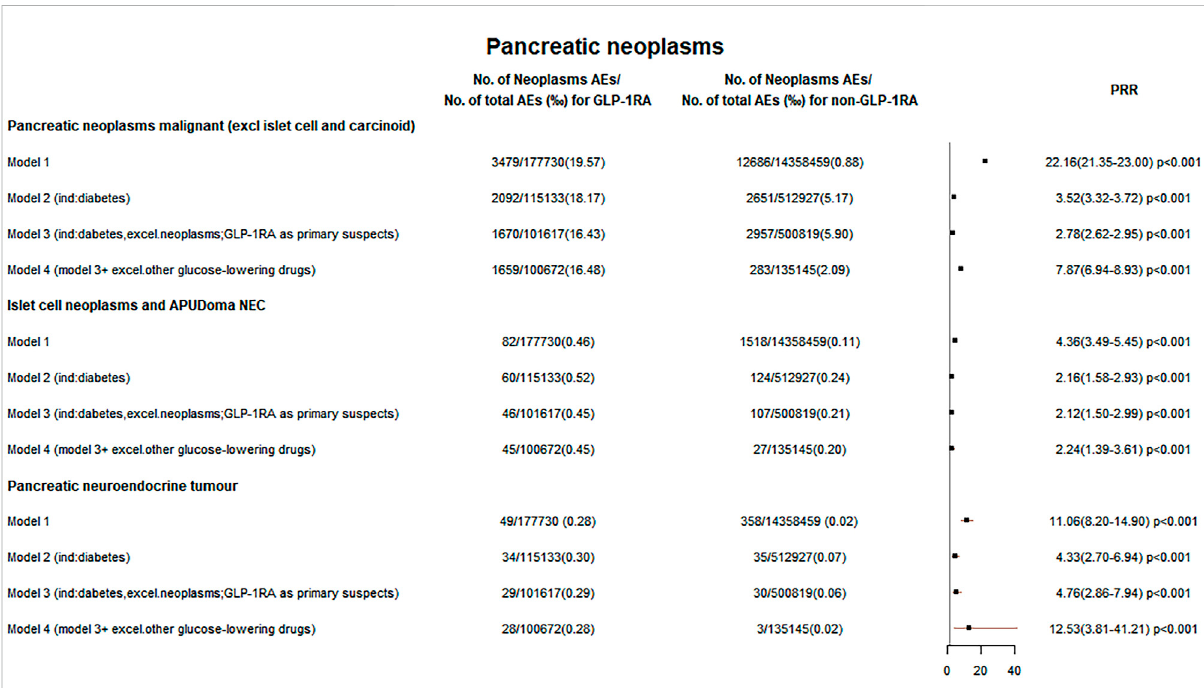
FIGURE 3 Pancreaticneoplasm reporting rates.ThereportingratesofGLP-1RA-associatedneoplasmswerecomparedwithdifferentcomparatorsinfour models: 1) other drugs excluding GLP-1RA (non-GLP-1RA) without indication restrictions; 2) non-GLP-1RA when diabetes as an indication; 3) non- GLP-1RA when the indication is limited to diabetes while excluding all tumors, and all cases with GLP-1RA as the “ primary suspect ” drug; and 4) all cases combining other glucose-lowering drugs were excluded on the basis of model 3 for